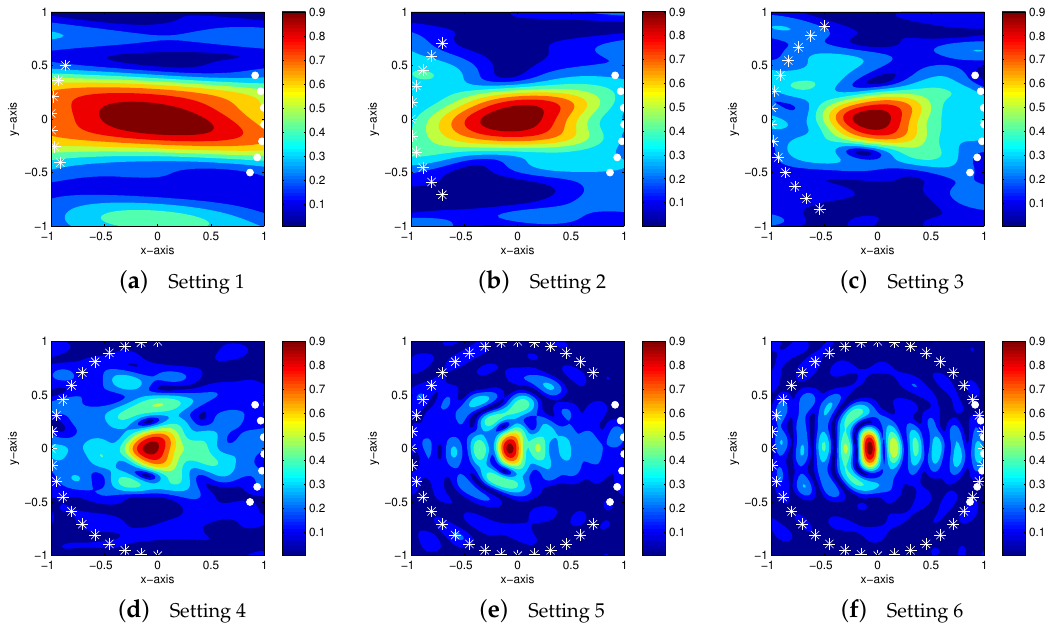
Figure 4. Maps of f SM ( x ) . White colored marks o and (cid:63) denote the incident and observation directions,